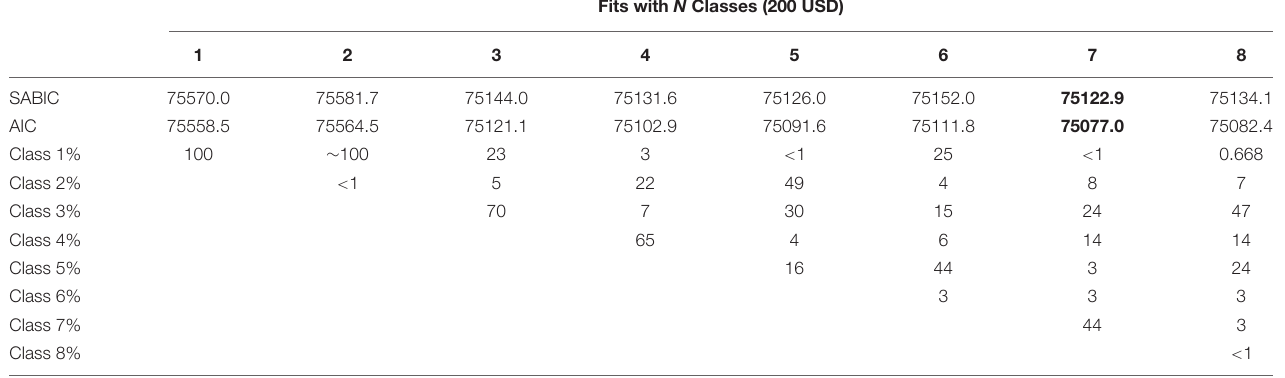
Fits with N Classes (200